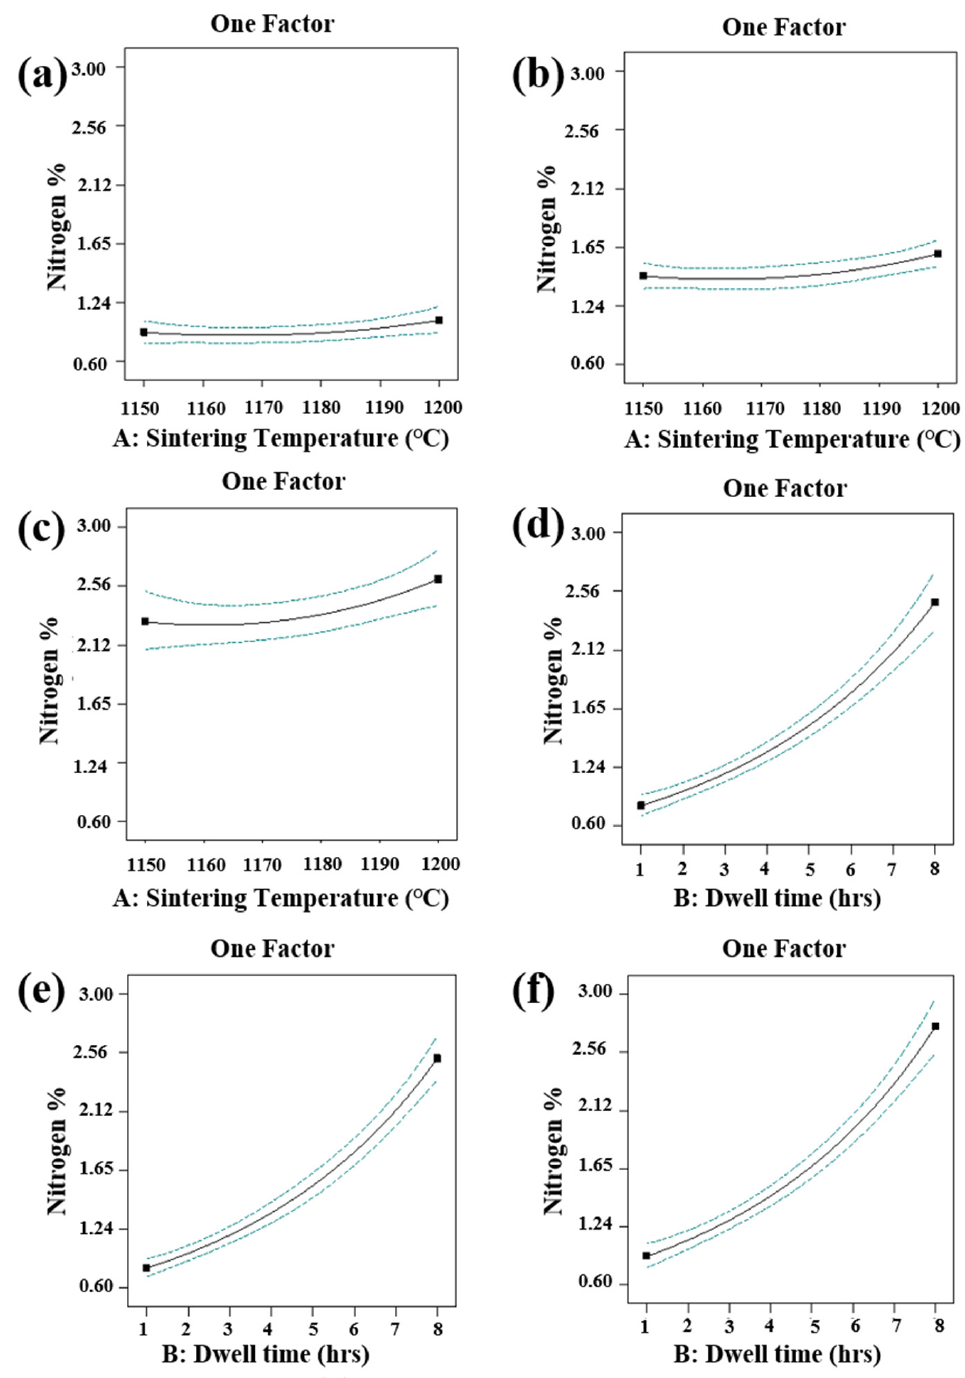
Figure 10. One factor effect plot for nitrogen absorption.